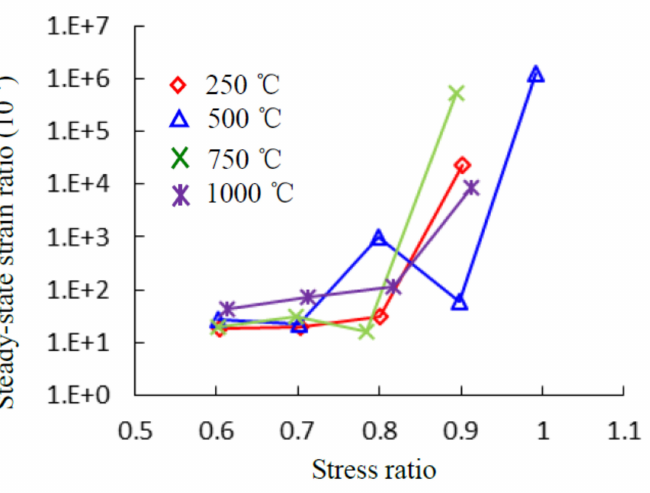
Figure 13. Permeability evolution of pre-cracked red sandstone after heated at different temperature. ( a ) T = 250 ◦ C; ( b ) T = 500 ◦